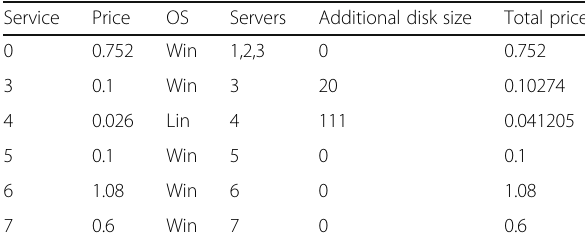
Table 8 Results of service consolidation for the tested application on amazon